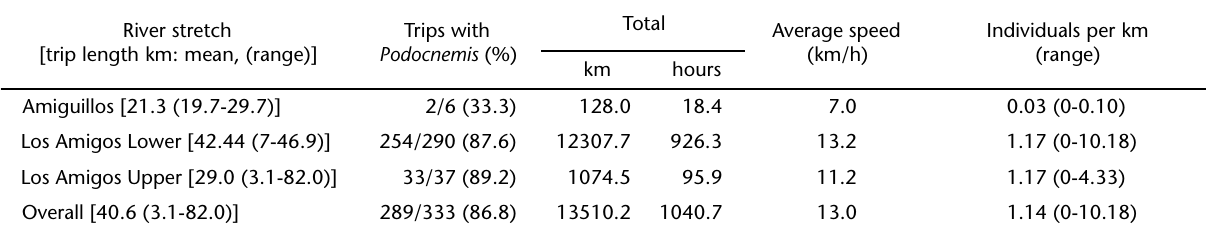
Table I. Summary of boat survey sampling effort with detection rates and number of P. unifilis individuals recorded per kilometer along three sections of river around the Los Amigos Biological Station, Amazonian Peru. River stretch Trips with [trip length km: mean, (range)] Podocnemis